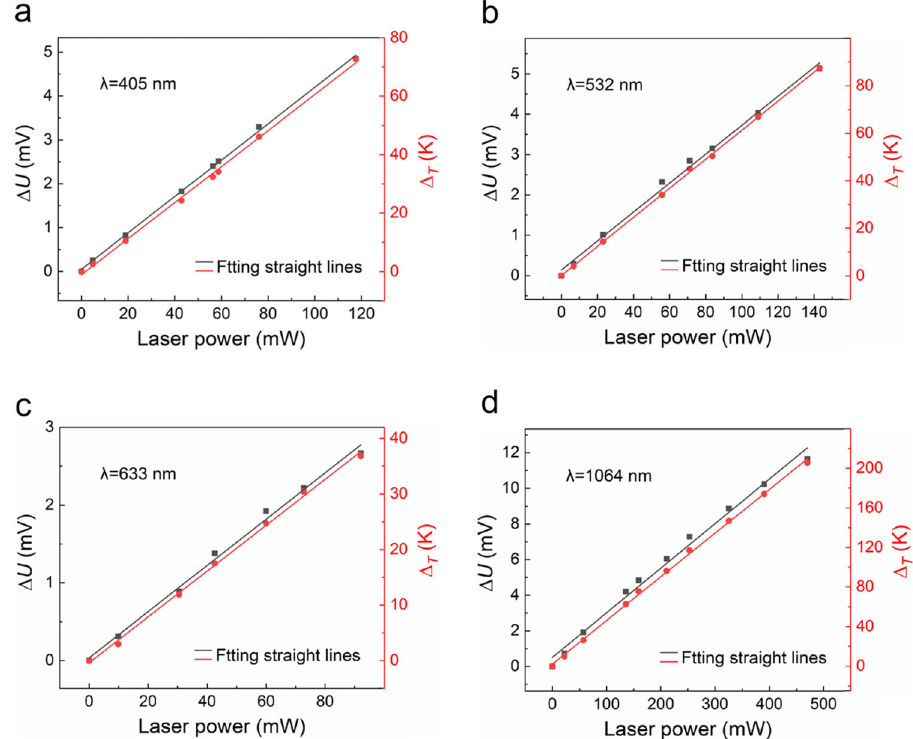
Fig. 6 The relationship between Δ U , Δ T and Laser power. a – d Δ U – laser power and Δ T – laser power curves measured when the AgNSF/CNTF heterojunction was irradiated by lasers with wavelengths of a 405, b 532, c 633, and d 1064 nm, respectively.